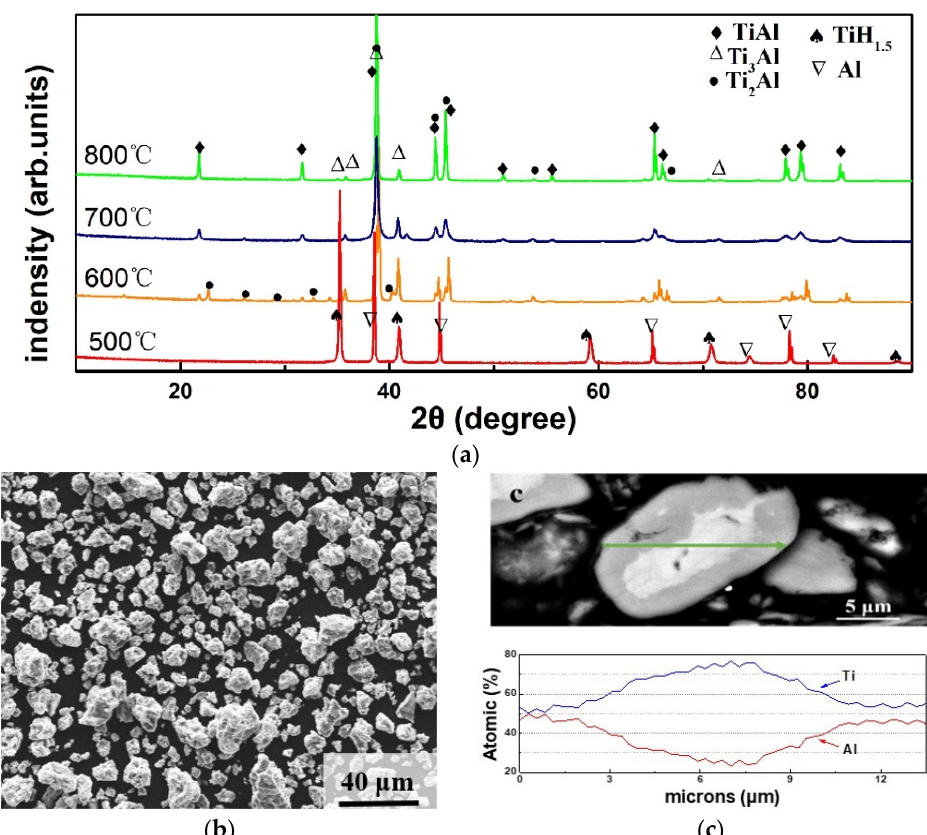
Figure 3. ( a ) X-ray diffraction (XRD) spectra of pre-alloyed powders prepared at different temperatures, ( b ) Pre-alloyed (PA) powder prepared at 800 °C, and ( c ) the cross section and composition distribution of the PA powder prepared at 800 °C. According to the Ti-Al phase diagram (shown in Figure 4) [4], the Ti-48Al alloy starts to solidify at 1456 °C. With cooling (top → bottom analysis), the composition of Ti-48Al alloy gradually narrows. The mechanism is the thermodynamic feasibility of the melting